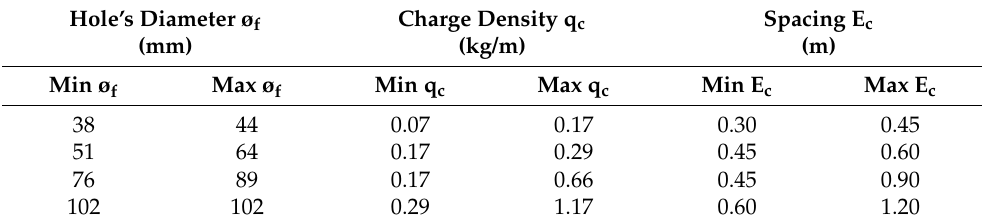
Table 1. Range of parameters commonly adopted for